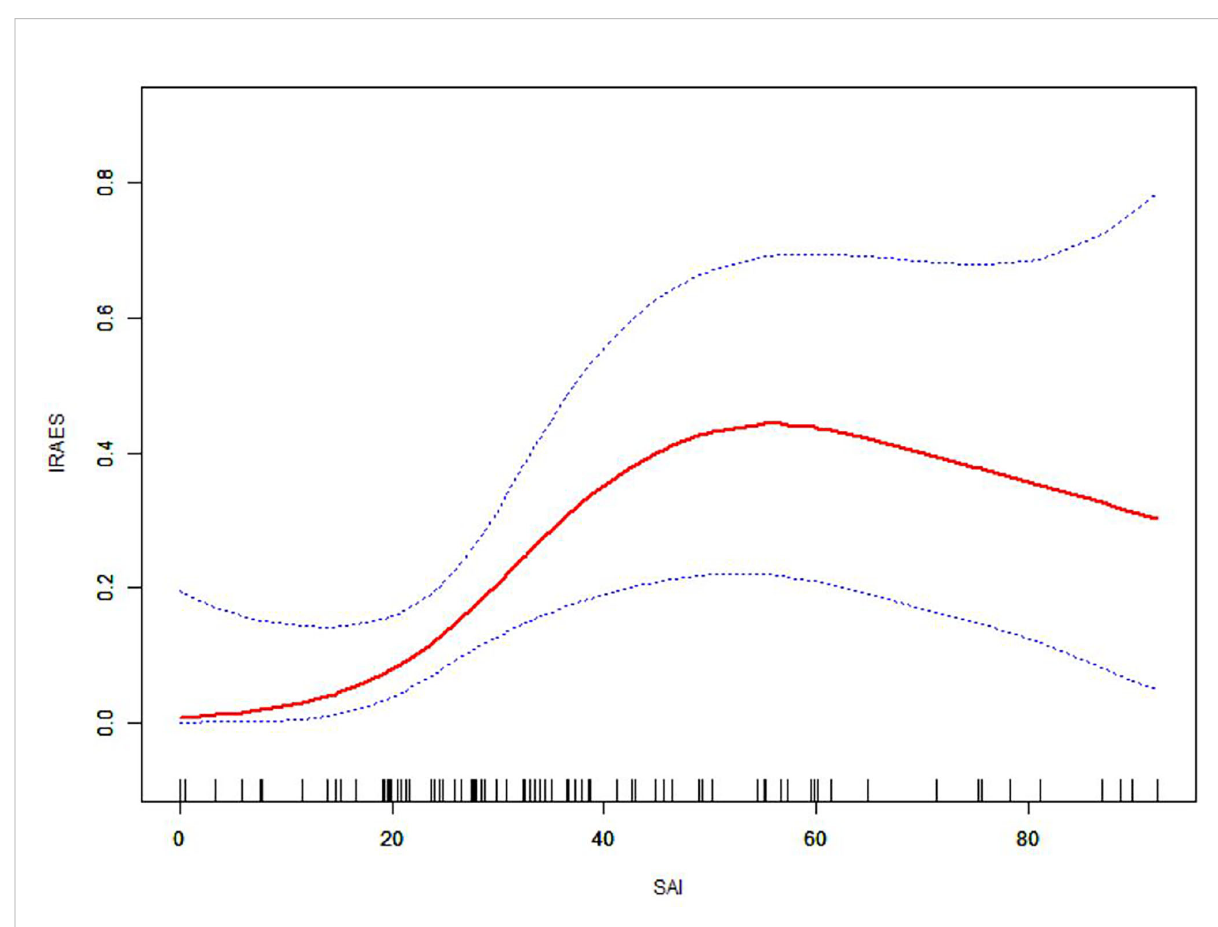
FIGURE 1 The relationship between subcutaneous adipose index and